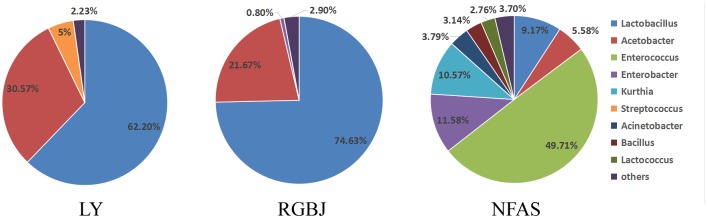
Distribution of bacteria in the acid slurry at the genus level.